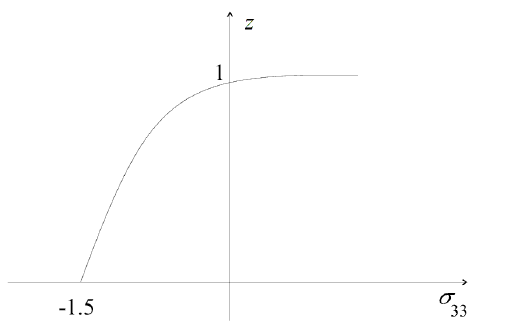
Figure 3. Plot of the function